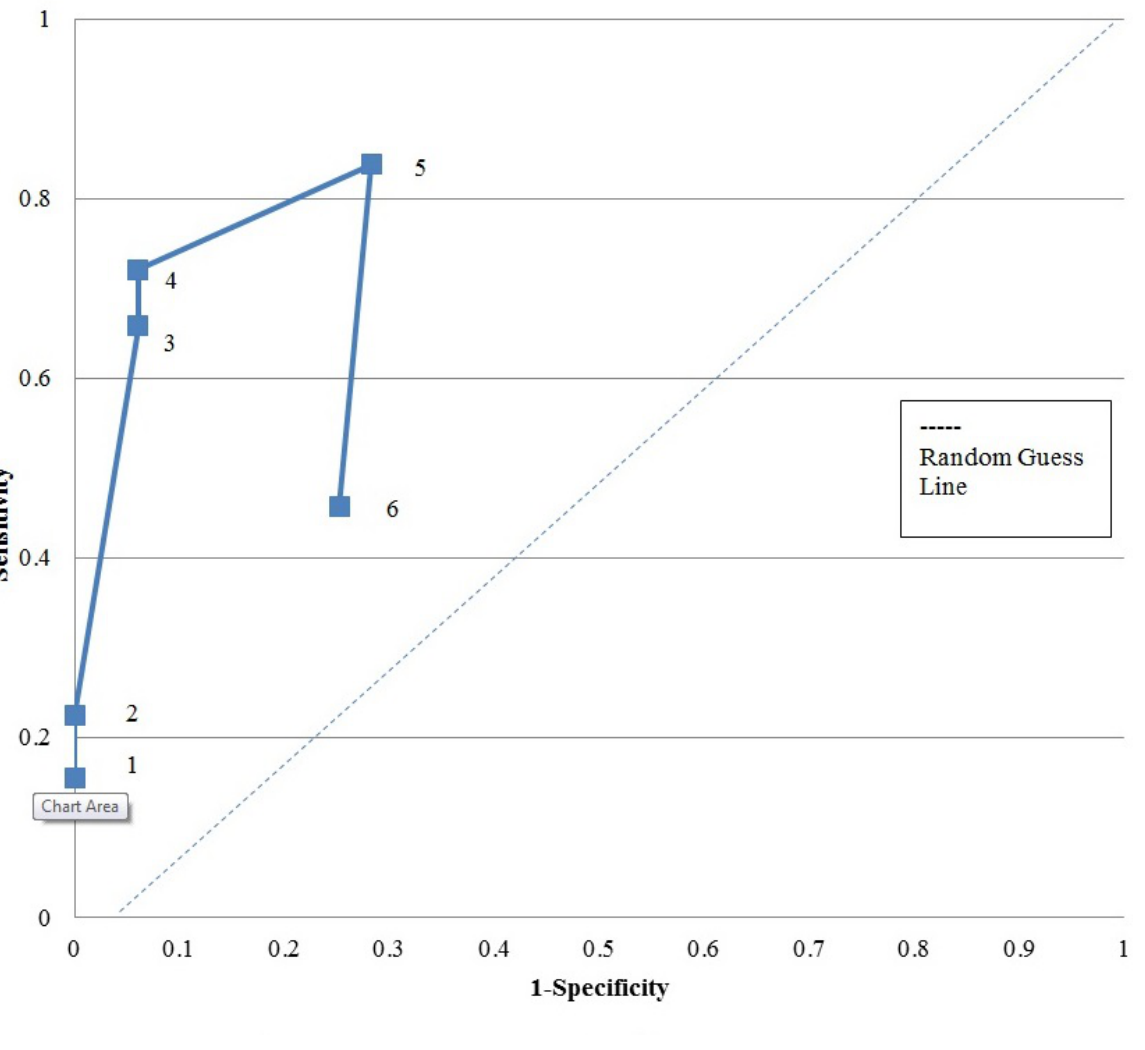
Figure 1. Receiver operating characteristics (ROC) curve of matching methods (1=insurance and phone, 2=insurance only, 3=phone only, 4=insurance or phone, 5=insurance, phone, or address, 6= address